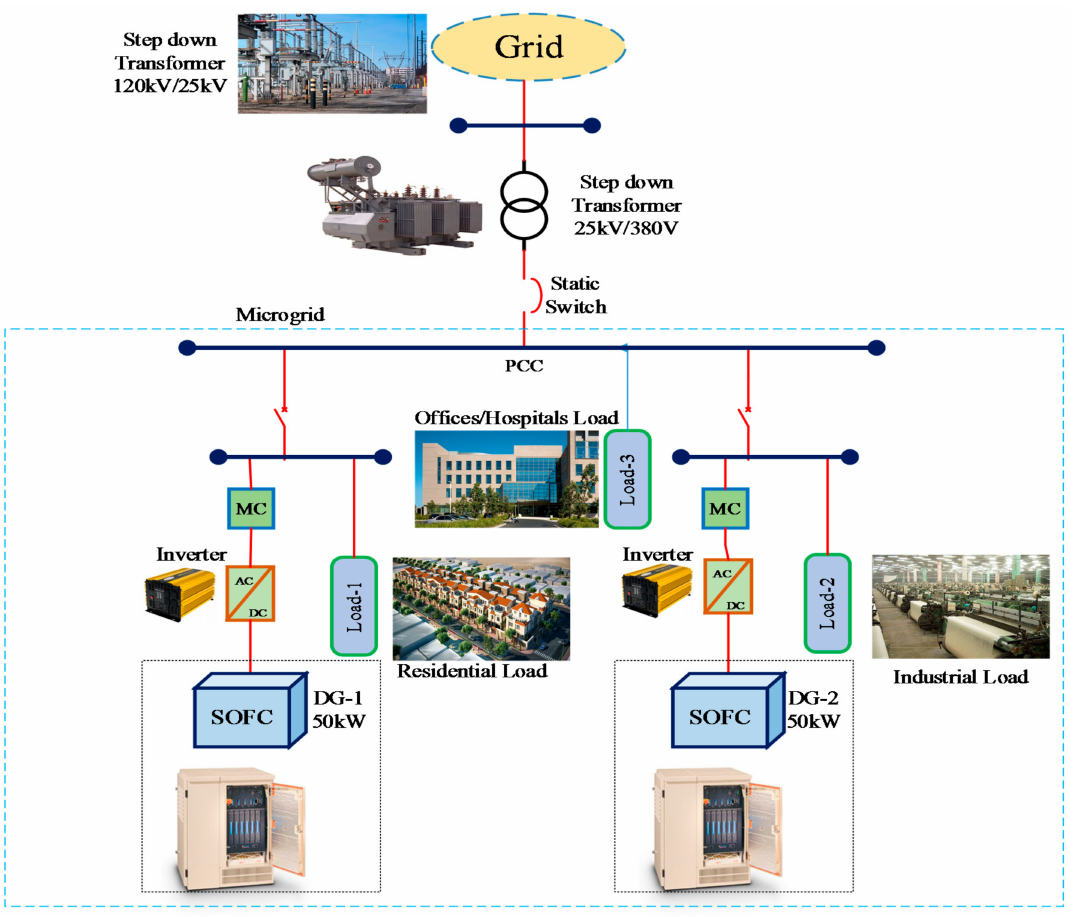
Figure 1. Block diagram of the proposed modified model for a grid connected MG incorporating